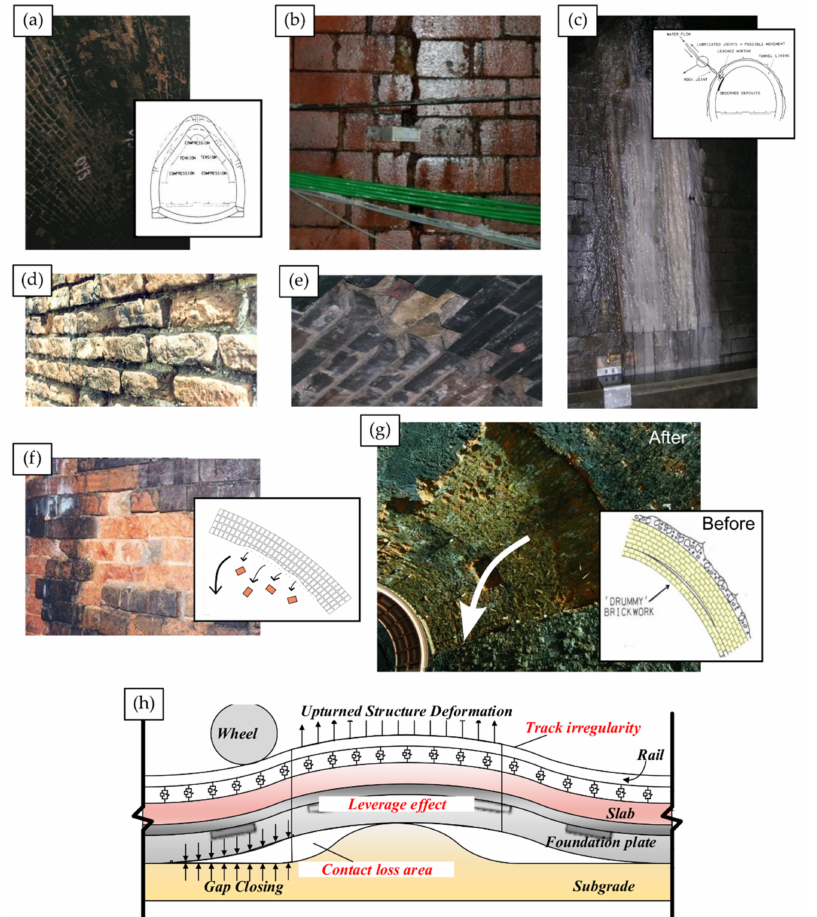
Figure 12. Common defects in masonry railway tunnels: ( a ) Haunch Deformation; ( b ) Cracks; ( c ) Water Ingress; ( d ) Perished Mortar; ( e ) Missing/Loose Brickwork; ( f ) Spalling; ( g ) Ring Separation and Debonded Wall-Section; ( h ) Frost Heave